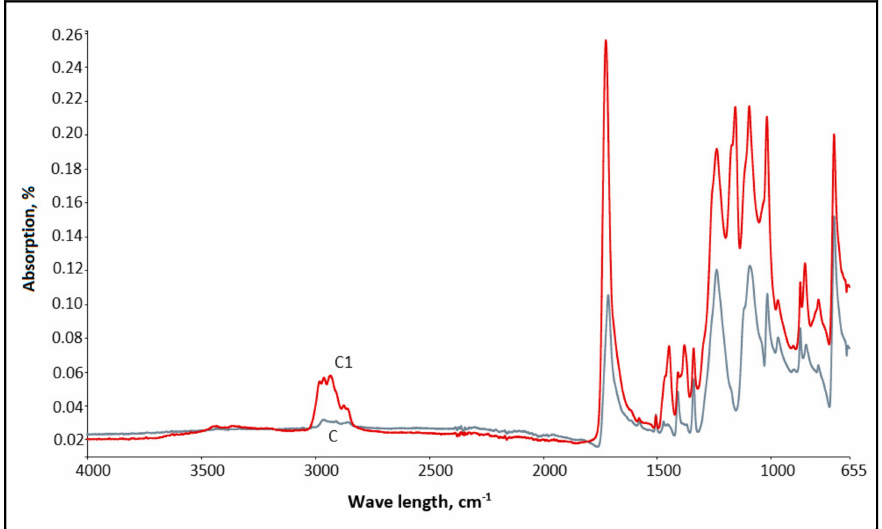
Figure 4. ATR spectrum of samples C and C1